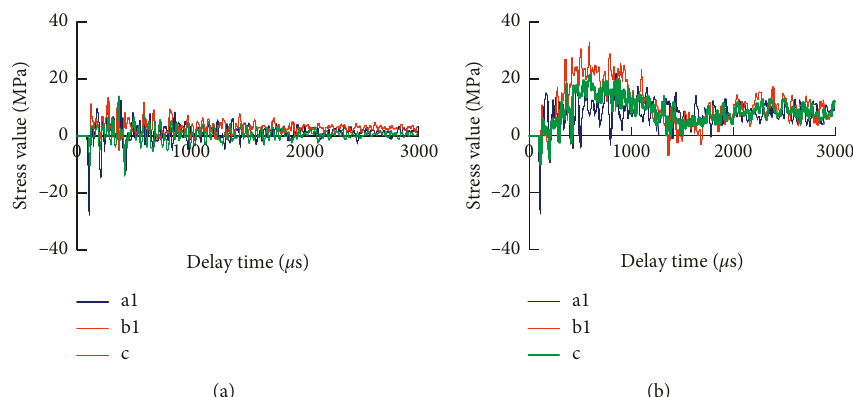
Figure 17: Stress concentration curve of elements of TBH hole wall before TBH initiation when the delay time is 3ms. (a) The PBH is a round hole. (b) The PBH is a notch hole.